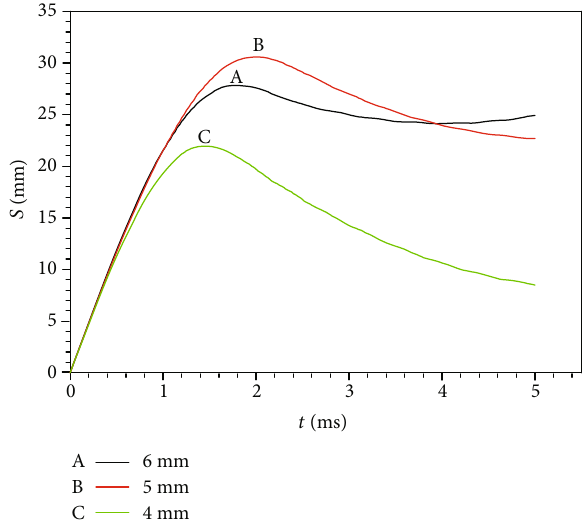
Figure 5: Comparison of displacement-time curves of the moving object for metal tubes of di ff erent outer